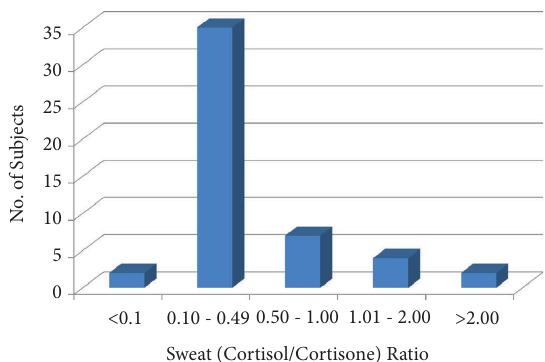
Figure 3: Sweat cortisol-cortisone ratio in healthy volunteer